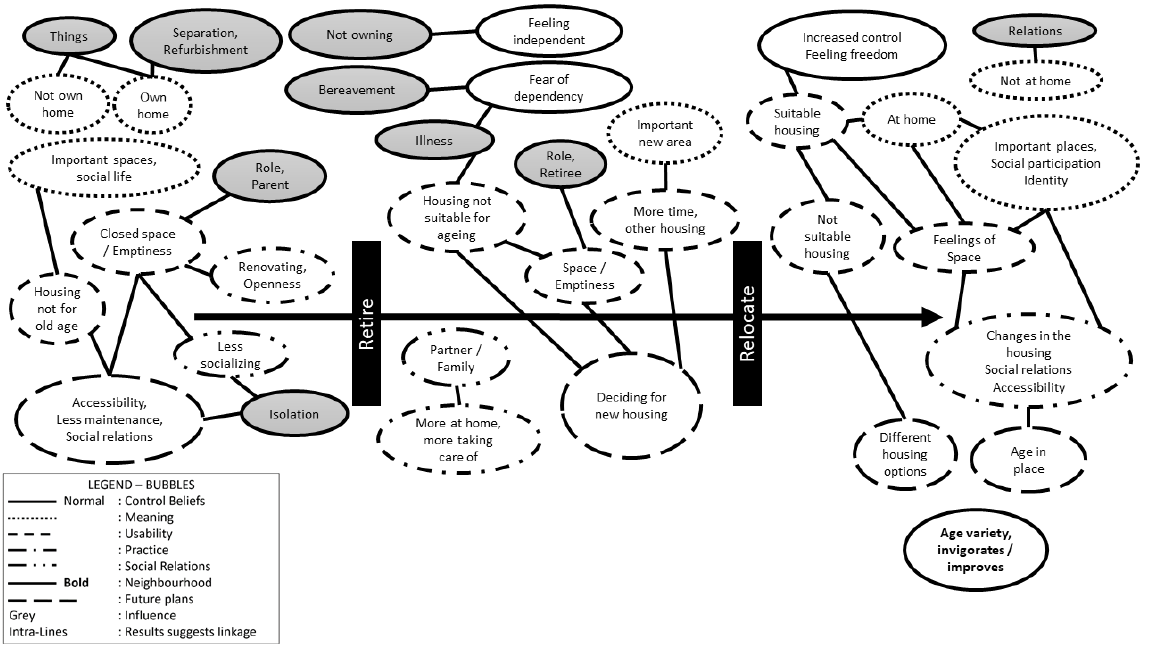
Figure A2. Joint situational map showing macrocodes in a timeline arrow for persons that had retired before relocating. The legend shows aspects of perceived housing, influencing macrocodes, and suggested linkages between macrocodes.